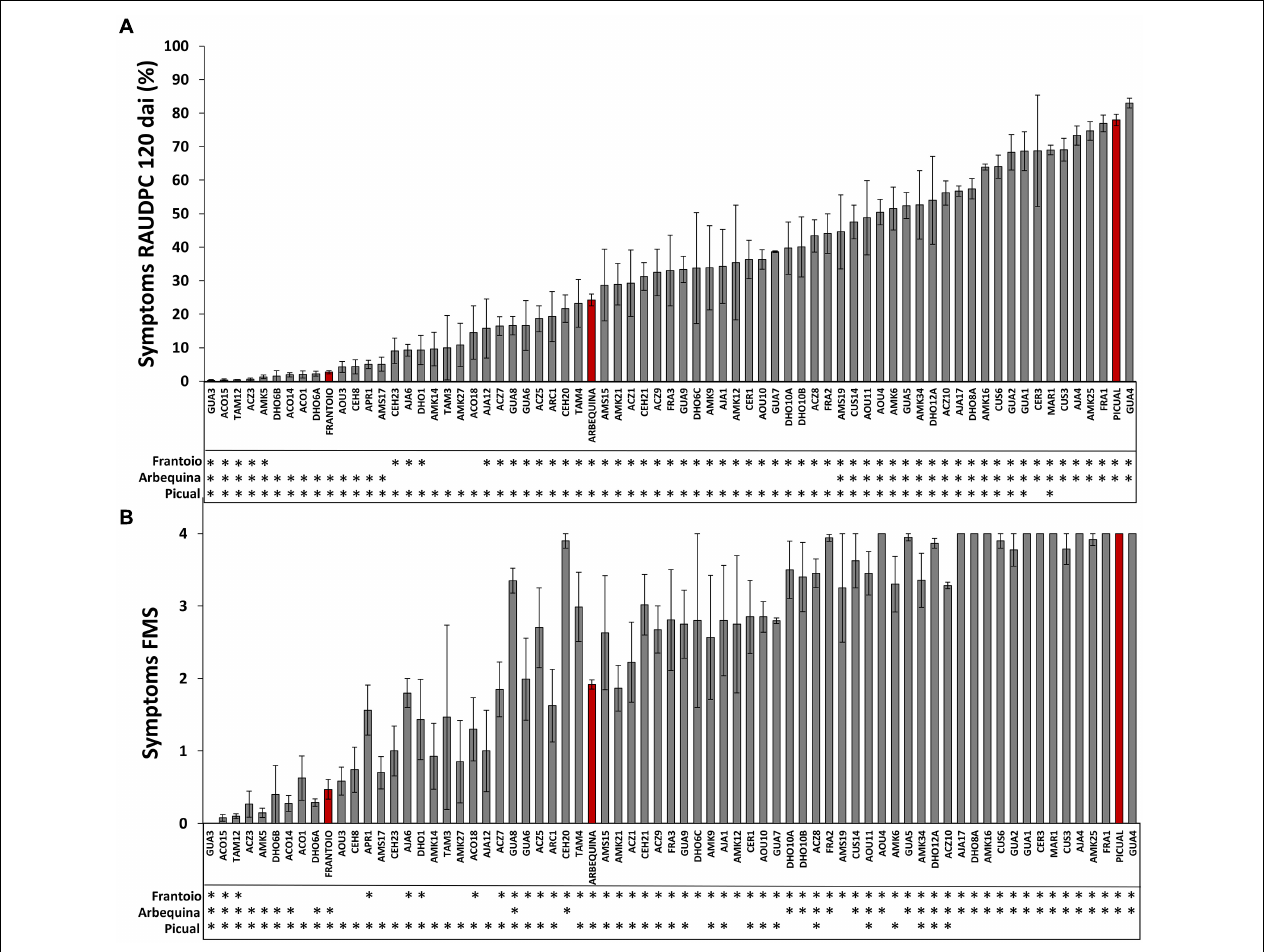
FIGURE 2 | Symptoms of infection of olive genotypes inoculated with the Verticillium dahliae defoliating isolate VD117. The Relative Area Under the Disease Progress Curve (RAUDPC) (A) and the Final Mean Severity (FMS) (B) of all wild olive genotypes was evaluated at 120 days after inoculation (dai). Red bars correspond to the reference cultivars: the resistant Frantoio (RAUDPC < 10, FMS < 1.5 and PDP = 0); the moderately susceptible Arbequina (RAUDPC 31–50, FMS 1.5–2.5 and PDP = 0–30); and the extremely susceptible Picual (RAUDPC > 71, FMS > 3.0 and PDP > 51), according to the levels of resistance described by López-Escudero et al. (2007). Asterisks indicate significant differences with cvs. Frantoio, Arbequina, and Picual, respectively. Results are the mean of 24 plants and error bars correspond to the standard error. Data were subjected to analysis of variance (ANOVA) and multiple comparisons of means were analyzed by LSD (Least Significant Difference) at P = 0.05. Multiple range test was performed by Statistix 9.0 (Analytical Software, Tallahase, FL, United